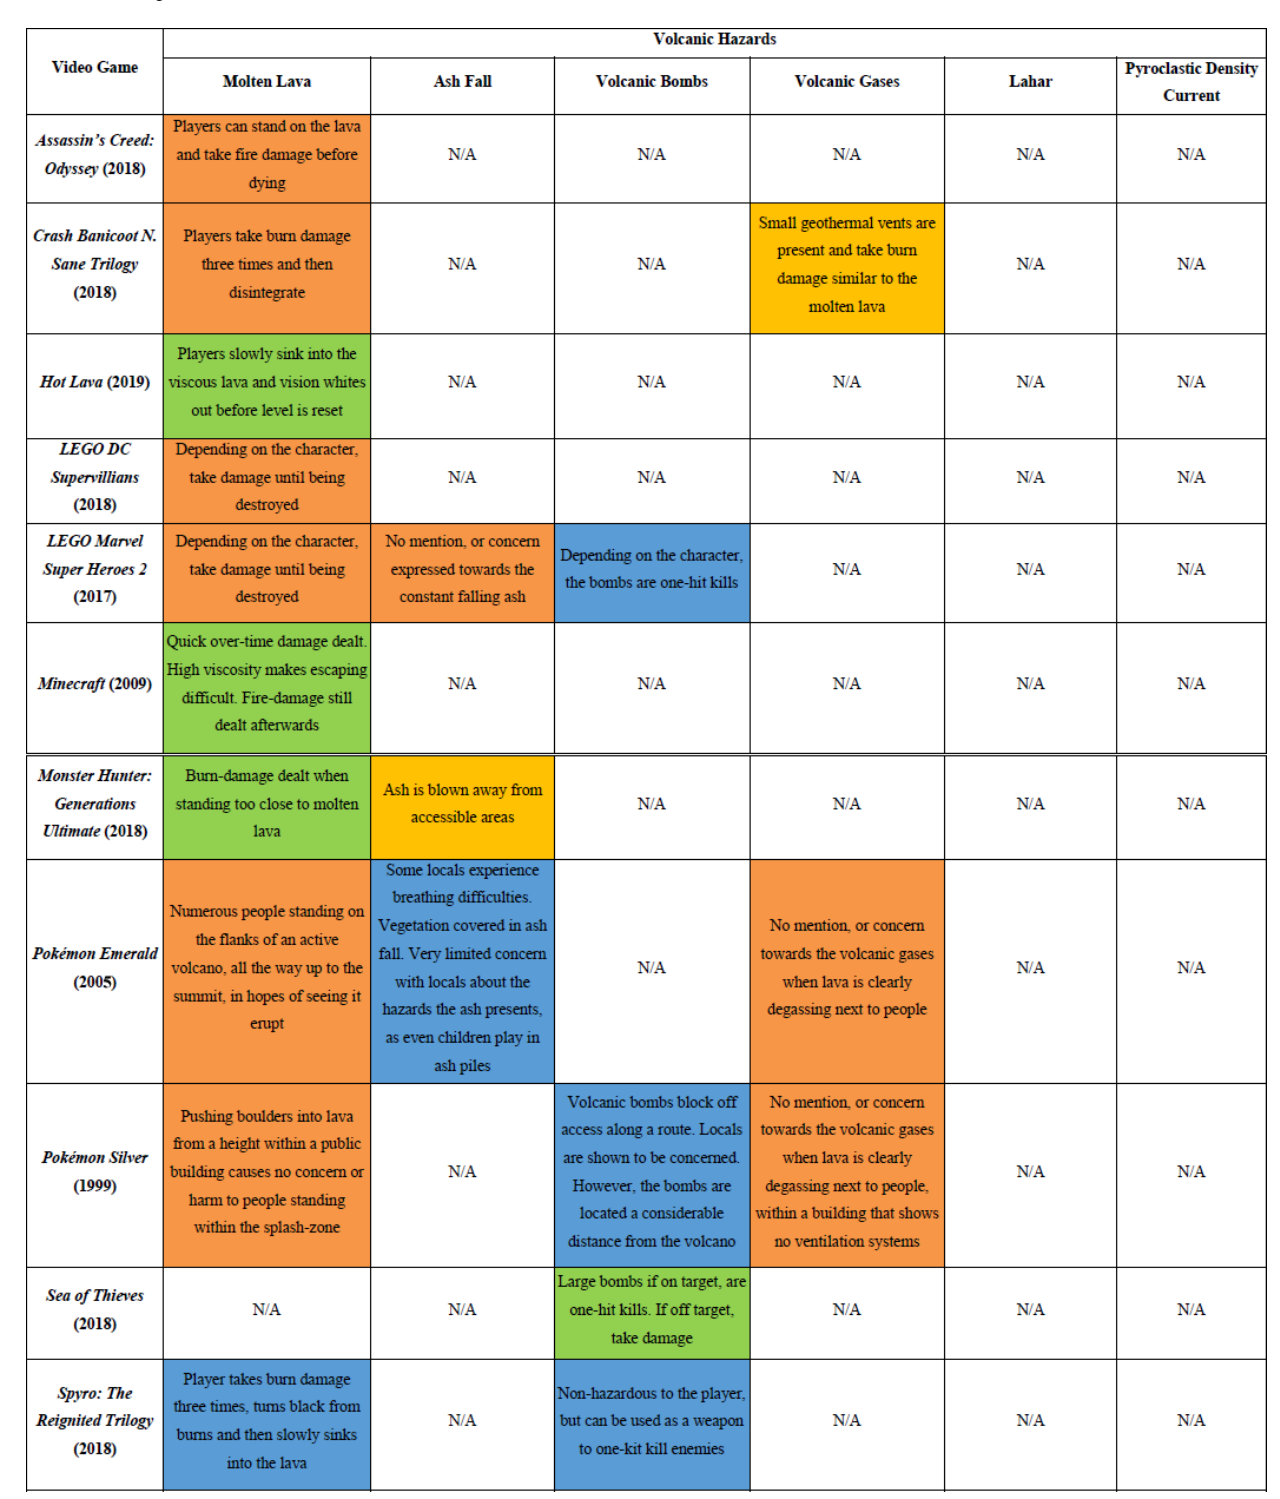
Table 2. A summary of volcanic hazards in individual COTS video games. Features are colour-coded based on if they are realistic (green), unrealistic (orange), or both realistic and unrealistic (blue) and if there was insufficient data to determine accuracy (yellow) or not applicable due to no examples (N/A;